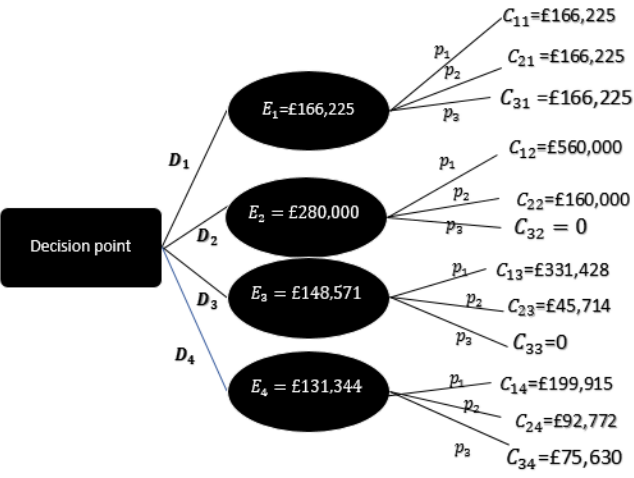
Figure 4. Two-stage scenario tree where stage1 includes the decision point (i.e., time when the investment decision is made) and stage 2 includes the uncertainty resolution, involving calculations on total system costs C ij and the corresponding expected values E j , where i ∈ { 1,2,3 } is the scenario index, and j ∈ { 1,2,3,4 } is the decision index, for each of the four investment decisions D 1 , D 2 , D 3 , D 4 .